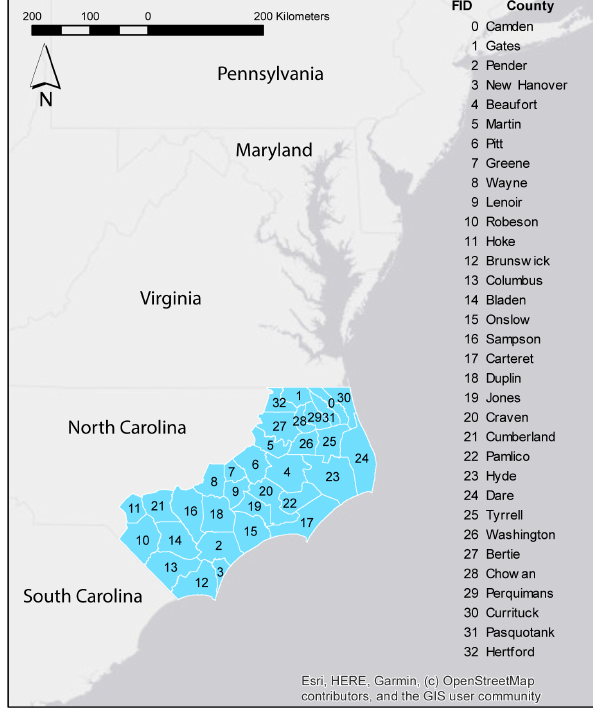
Figure 1. Orientation map of North Carolina counties that